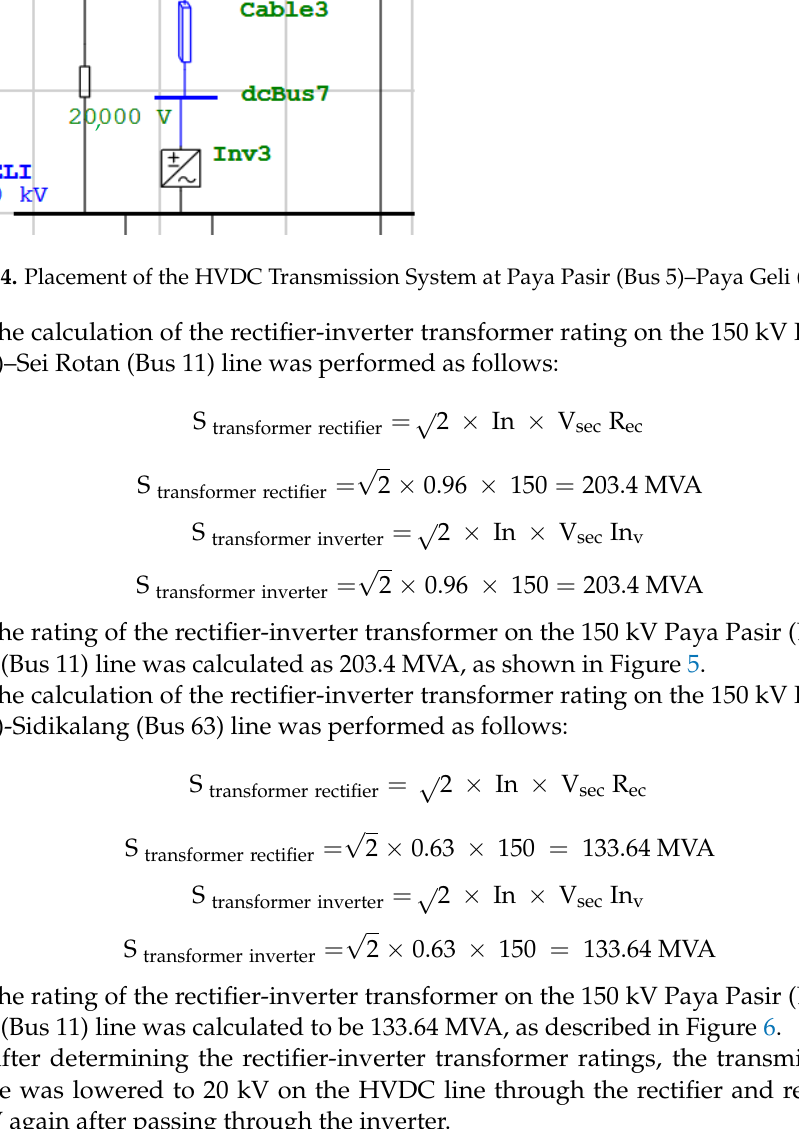
(Bus 7) line was found to be 179.77 MVA, as shown in Figure 4.